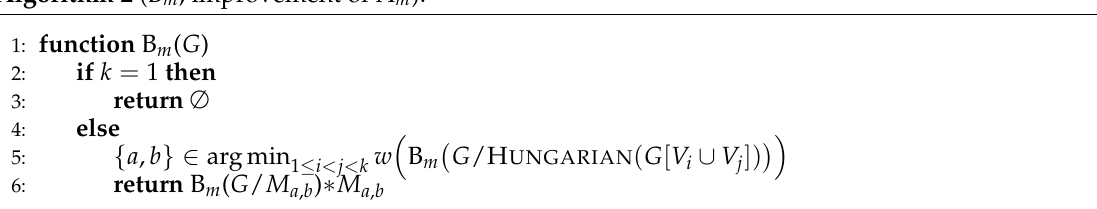
Algorithm B m searches through all possible pairs ( V i , V j ) of partitions, recursively runs on the quotient graph G / M , where M is the optimal 2-assignment on V i ∪ V j , and among these